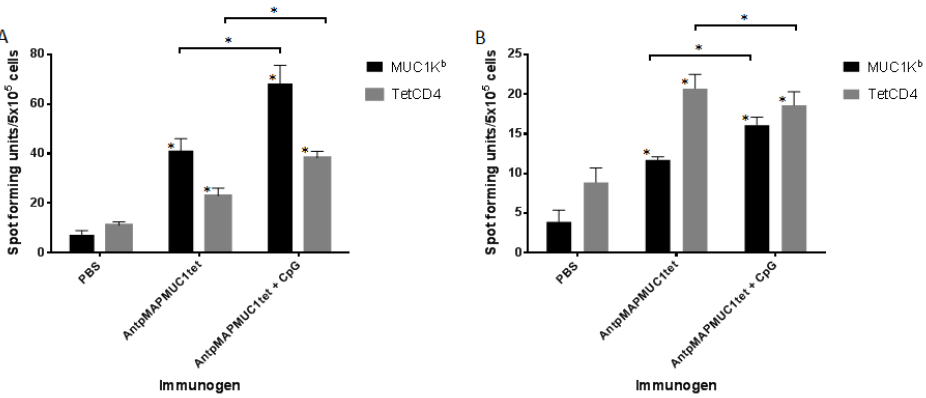
Figure 9. Long term in vivo IFN-γ and IL-4 responses to AntpMAPMUC1tet and AntpMAPMUC1tet + CpG. C57BL/6 mice were injected i.d on day 0, 10 and 17 with PBS, 100 µg AntpMAPMUC1tet and AntpMAPMUC1tet + CpG. Number of IFN-γ secreting cells ( A ) and IL4-secreting cells ( B ) to MUC1K b (SAPDTRPAP) and tetCD4 antigens were analysed by ELISpot assay. ConA (1 µg/mL) was used as an internal positive control (not shown). Results are shown as mean spot-forming units (SFU)/5 × 10 5 cells ± SEM. Results are representative of three separate experiments. * p < 0.05. To detect long termMUC1K b restricted lysis C57BL/6 mice were injected with CFSE labelled cells pulsed with SAPDTRPAP peptide as described previously. Mice pre-immunised with AntpMAPMUC1tet + CpG generated significantly greater ( p < 0.001) MUC1K b -specific lysis than mice immunised with AntpMAPMUC1tet peptide alone, 41 ± 2 vs 65 ± 2% (Figure 10A,B). Figure 10. Long term cellular immune responses in AntpMAPMUC1tet immunised mice, measured as in vivo CTL killing assays. ( A ) C57BL/6 mice were immunised i.d. with PBS, 100 µg AntpMAPMUC1tet or 100 µg AntpMAPMUC1tet + 50 µg CpG and the percent MUC1K b -specific lysis was determined eight days after immunisation calculated as: {[1 − (ratio CFSE low /CFSE high of PBS mice/ratio CFSE low /CFSE high of immunised mice)] × 100}. Representative histograms are shown. ( B ) Data is presented as mean % of killing ± SEM ( n = 6). ** p <0 .001.